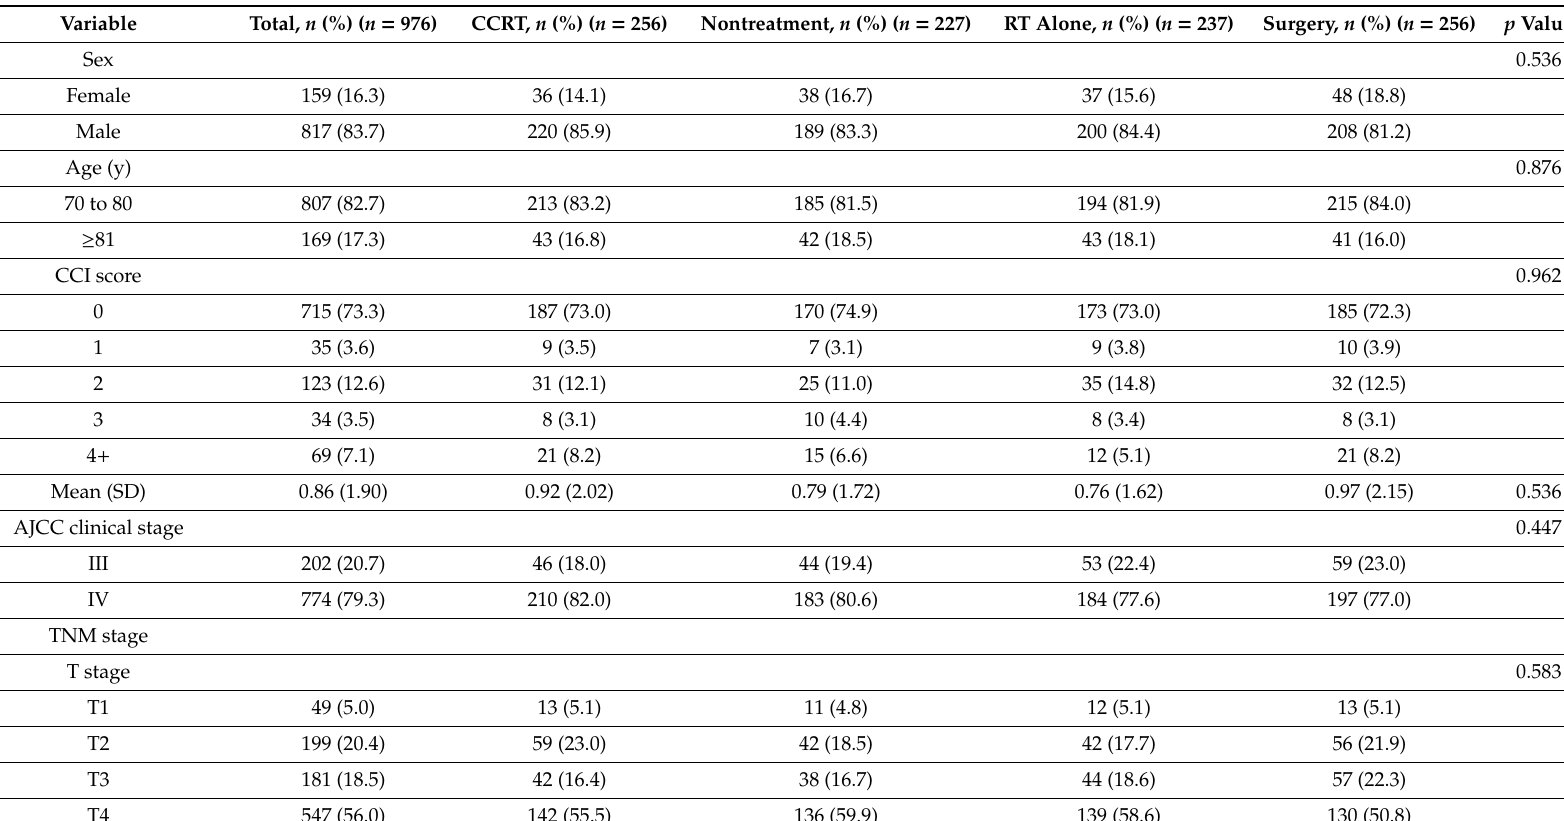
Table 1. Characteristics of Elderly Patients ( ≥ 70 years) with Locally Advanced Oral Cavity Squamous Cell Carcinoma who Received Di ff erent Treatments and Propensity-Score-Matched